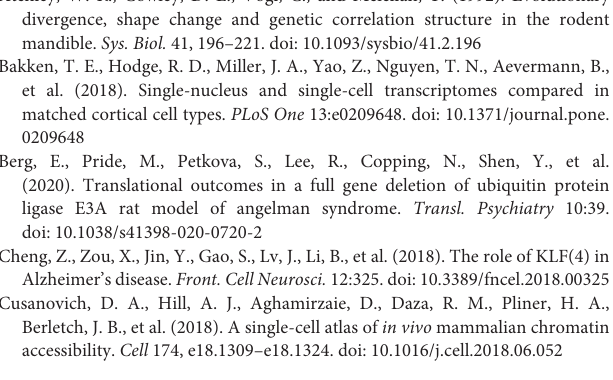
SUPPLEMENTARY FIGURE 1 | Cell-type-specific marker genes visualized by UMAP. SUPPLEMENTARY FIGURE 2 | Cluster UMAP of 11 libraries, each color represents a library in four cortical areas. SUPPLEMENTARY FIGURE 3 | Pie chart comparing the proportions of cell types. Refer to the single-cell nuclear transcriptome data of the human cerebral cortex published by Del-Aguila et al. (2019).